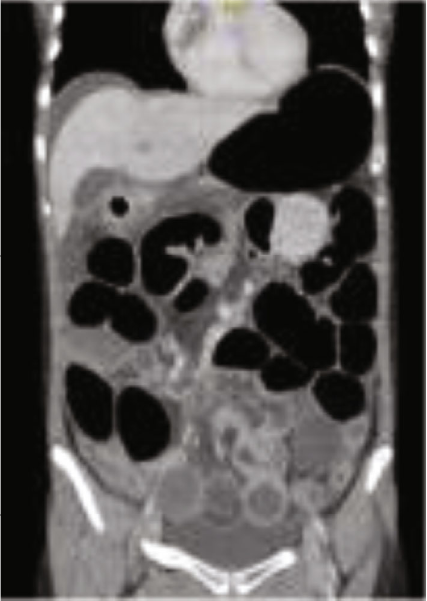
Figure 2: Computer tomography scan in the coronal plane demonstrating high-grade distal small bowel obstruction with a transition point within the left iliac fossa. Appearance of a “ target ” sign raising suspicion of an intussusception.